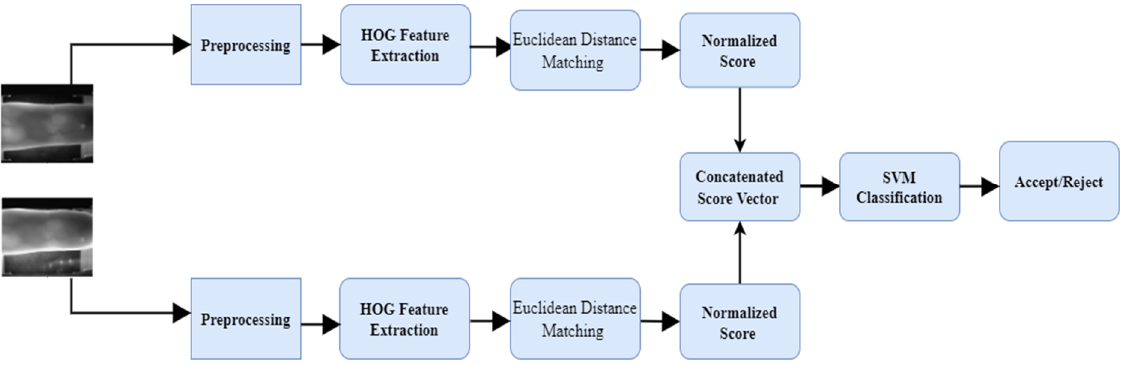
Figure 2 . The proposed Bayesian optimized SVM based fusion (BSBF) . Figure 2. The proposed Bayesian optimized SVM based fusion